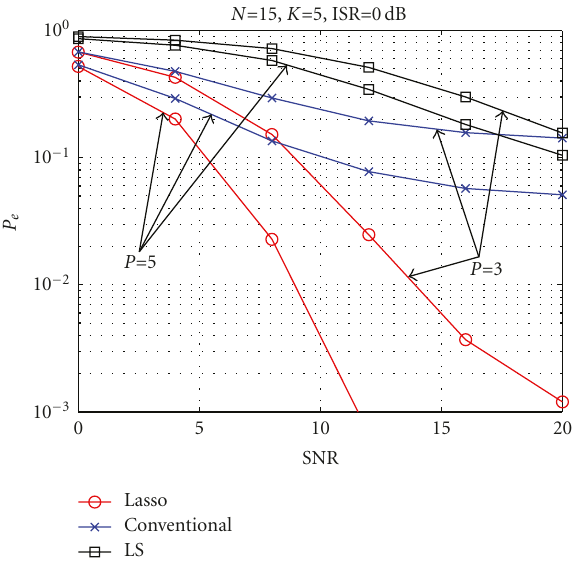
Figure 1: Probability of incorrect delay estimation versus SNR in a power-controlled scenario (chip-synchronous system with AWGN and known K ).